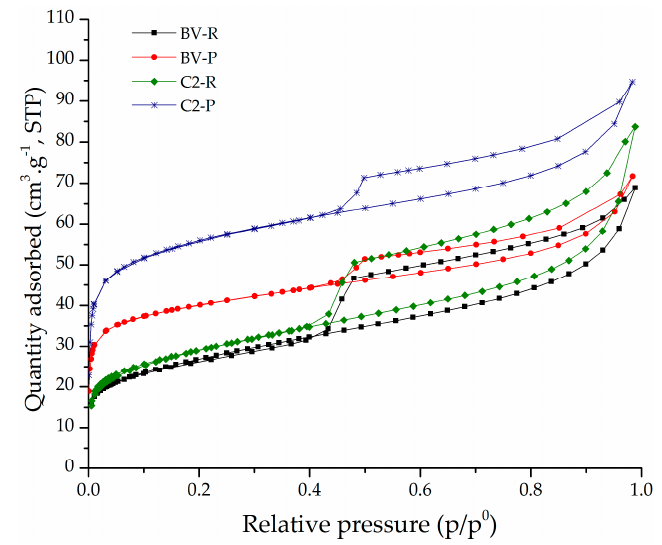
Figure 4. Horvath and Kawazoe micropore width distributions of refined (R) and pillared (P) forms of aluminosilicates C2 and